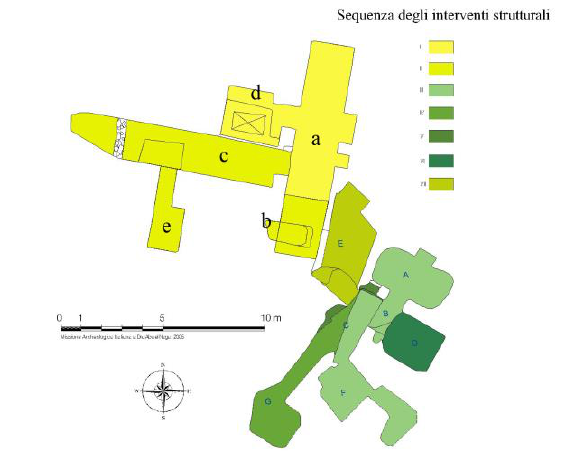
Figure 6. M.I.D.A.N.05 plan with different building